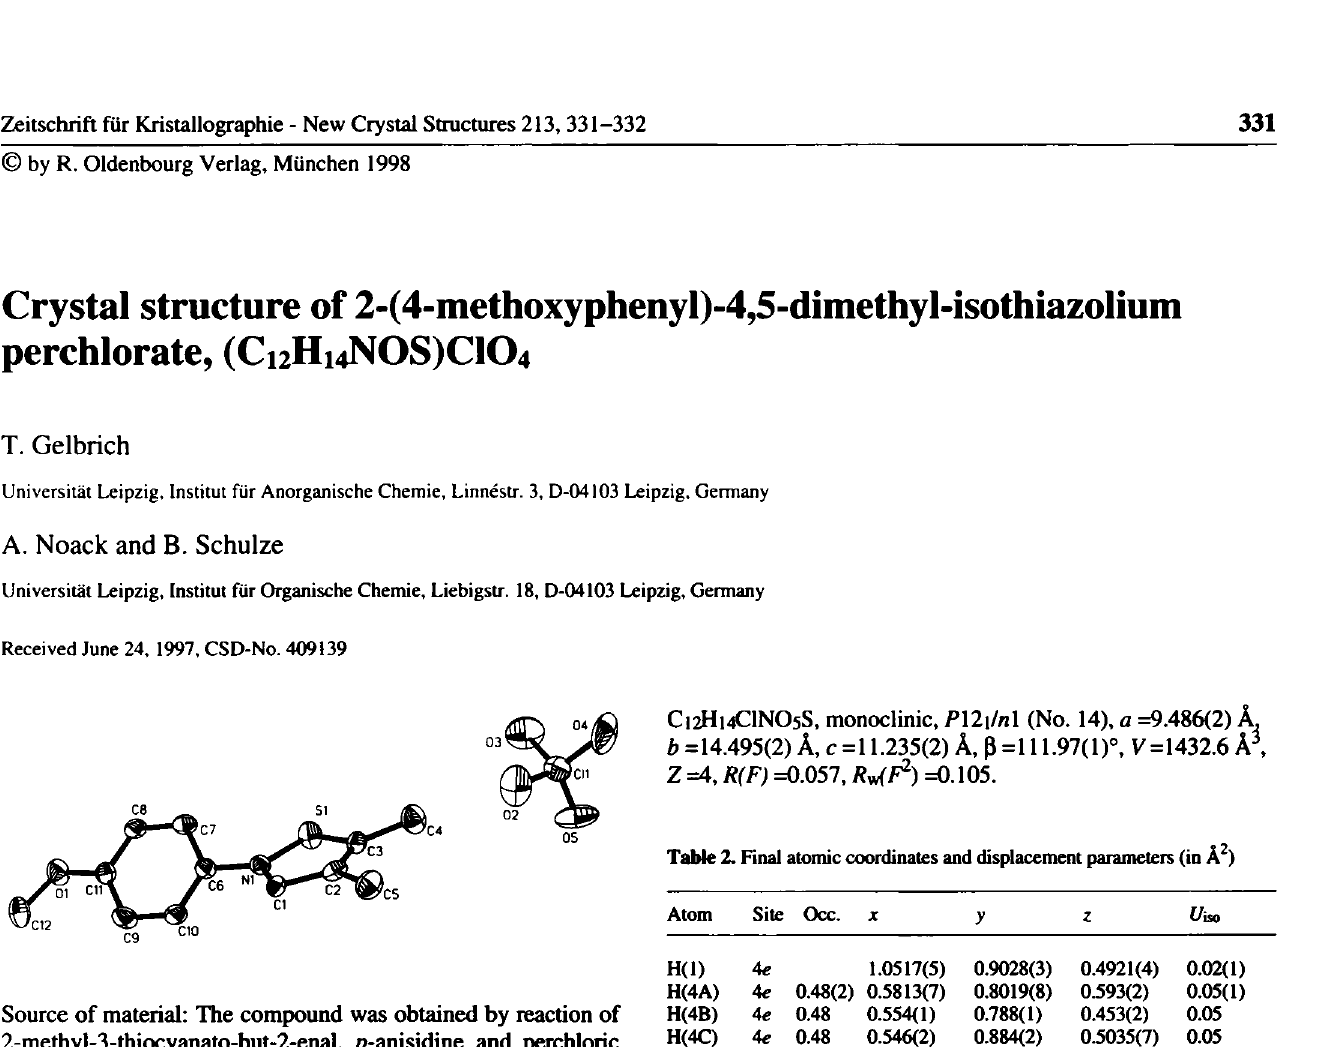
Table 2. Final atomic coordinates and displacement parameters (in